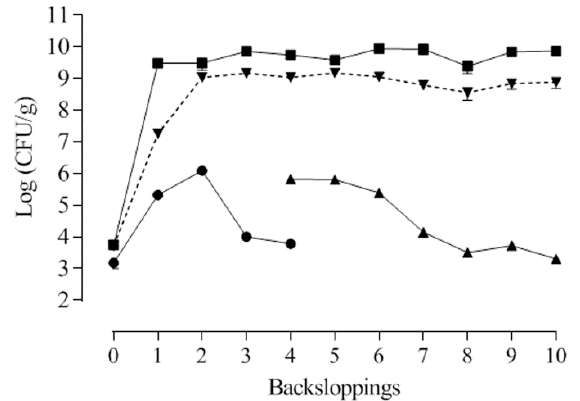
Figure 2. Lactic acid bacteria (dotted line), Enterobacteriaceae (triangle), yeasts (round), and total mesophilic count (square) concentrations (mean ± standard deviation) during the ten consecutive backsloppings in the spontaneous cricket powder fermentation.